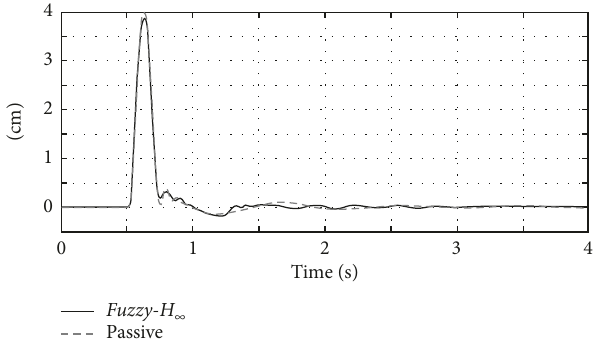
Figure 12: Front tire displacement ( Z